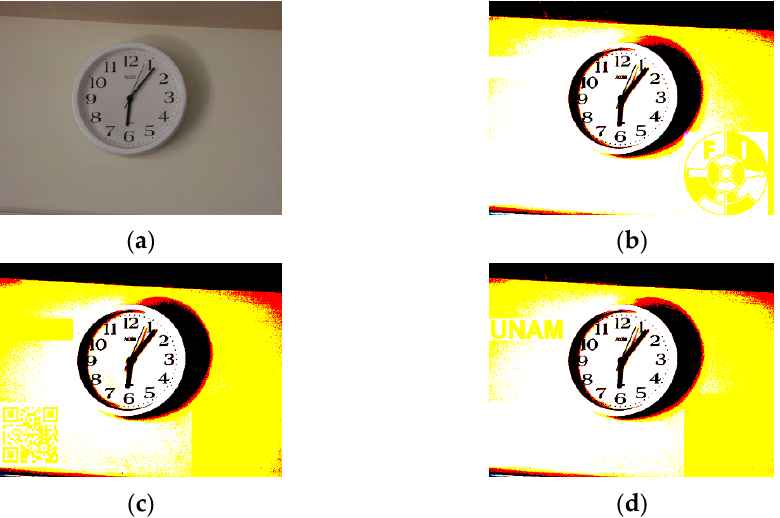
Figure 13. Histogram modulation-based exhibition strategy applied to the proposed algorithm, ( a ) Multi-Watermarked image, ( b ) Exhibited FI watermark, ( c ) Exhibited QR watermark, ( d ) Exhibited UNAM watermark.